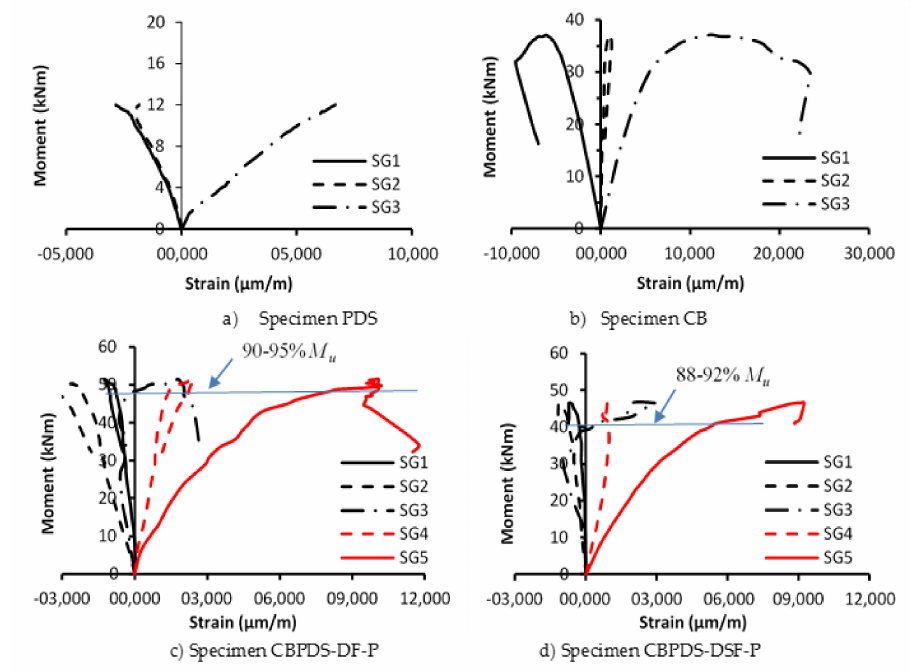
Figure 17. Moment versus strain